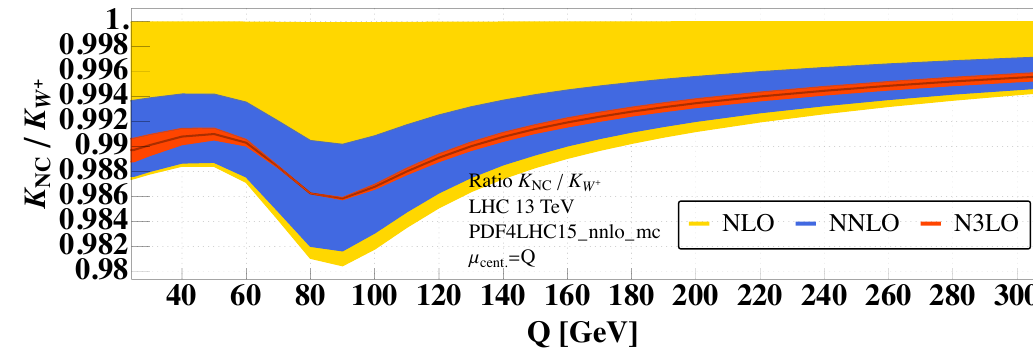
Figure 10. Ratio of the K-factors for NCDY and W + production as a function of Q 2 at different orders in perturbation